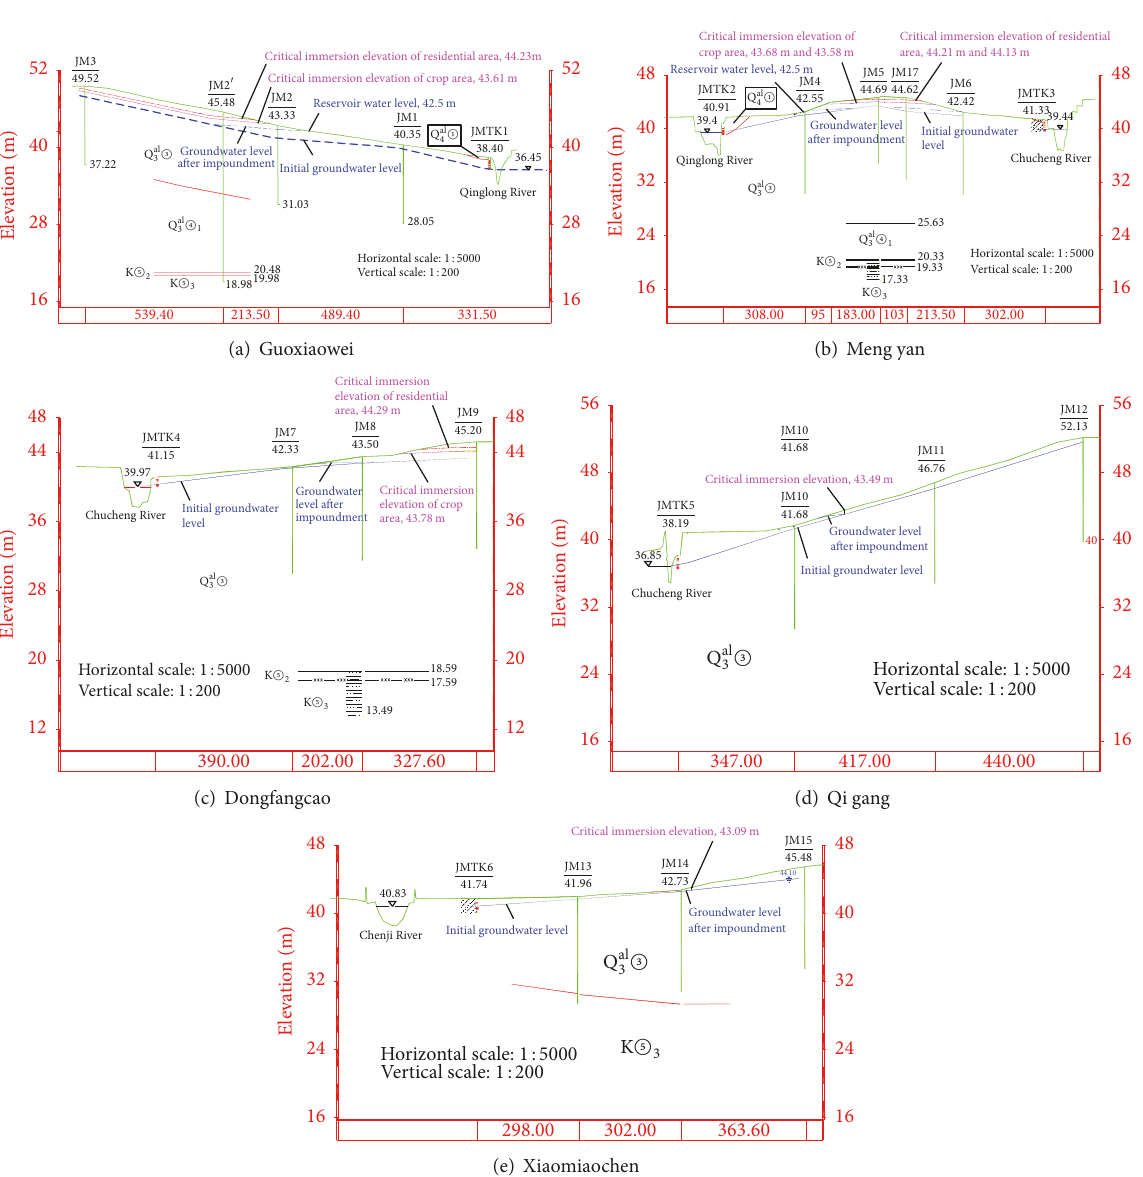
contour lines of 43.5 m and 44.0 m, but distances to profiles at Qigang and Xiaomiaochen are within the 43.5 m and 44.0 m contours. The signs “ − ” and “+” are used to represent the distance within and beyond the 43.5 m and 44.0 m lines, respectively. Consequently, the immersion elevation